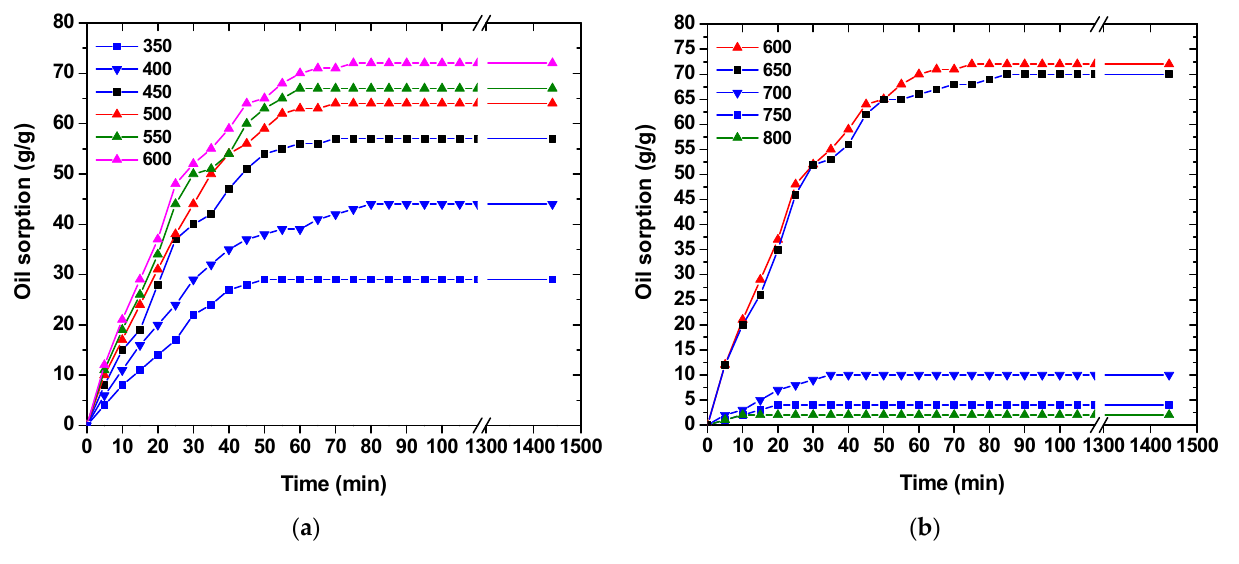
Figure 4. Effect of contact time on oil sorption capacity. ( a ) ACp-350, ACp-400, ACp-450, ACp-500, ACp-550, ACp-600; ( b ) ACp-600, ACp-650, ACp-700, ACp-750, ACp-800.